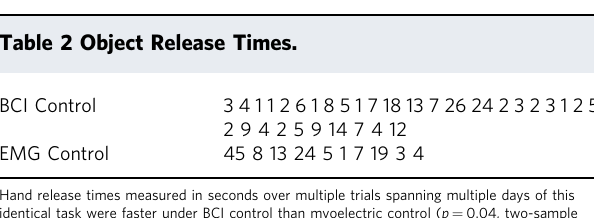
Theparticipantwasunabletoperformanyaspectofthetestwiththeunassisted,paralyzedarm.ConditionsperformedwiththeassistanceoftheMyoPropoweredorthosis,whetherundermyoelectricor brain-computerinterfacecontrol,areshowninnon-italicizedboldface.ConditionsperformedwiththeassistanceoftheMyoPropoweredorthosis,onlyunderbrain-computerinterfacecontrol,areshown in italicized